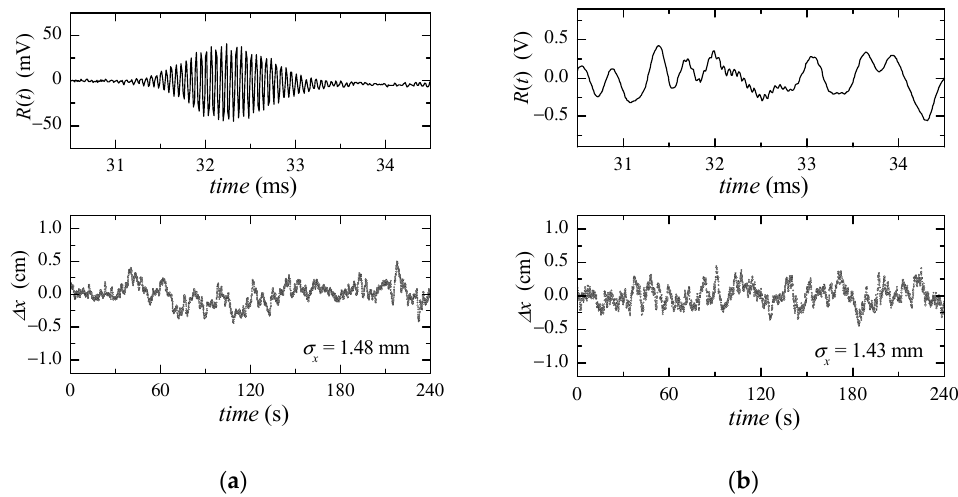
Figure 5. Plot of the signal received by the microphone (top) and of the error in the estimation of the distance (bottom) in a silent environment in repeated measurements over 4 min ( a ). Signal received by the microphone (top) and error in the estimation of the distance (bottom) in a noisy environment in repeated measurements over 4 min ( b ). Measurements reported in (b) were obtained with the peak-to-peak level of the ambient noise ten times larger than the maximum amplitude of the pulse in (b). During all measurements the microphone was located in a fixed position 4 m away from the speaker.